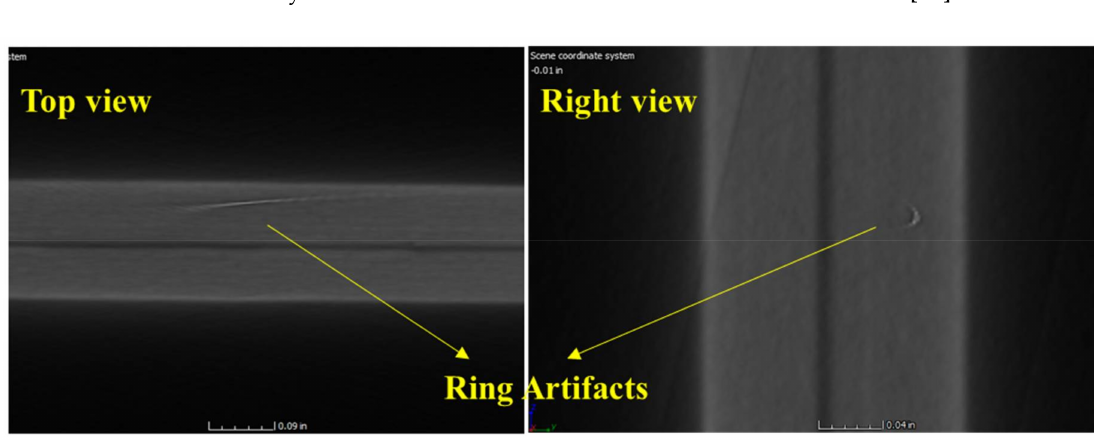
Figure 24. Location of the bright lines inside the battery from the new smartphone